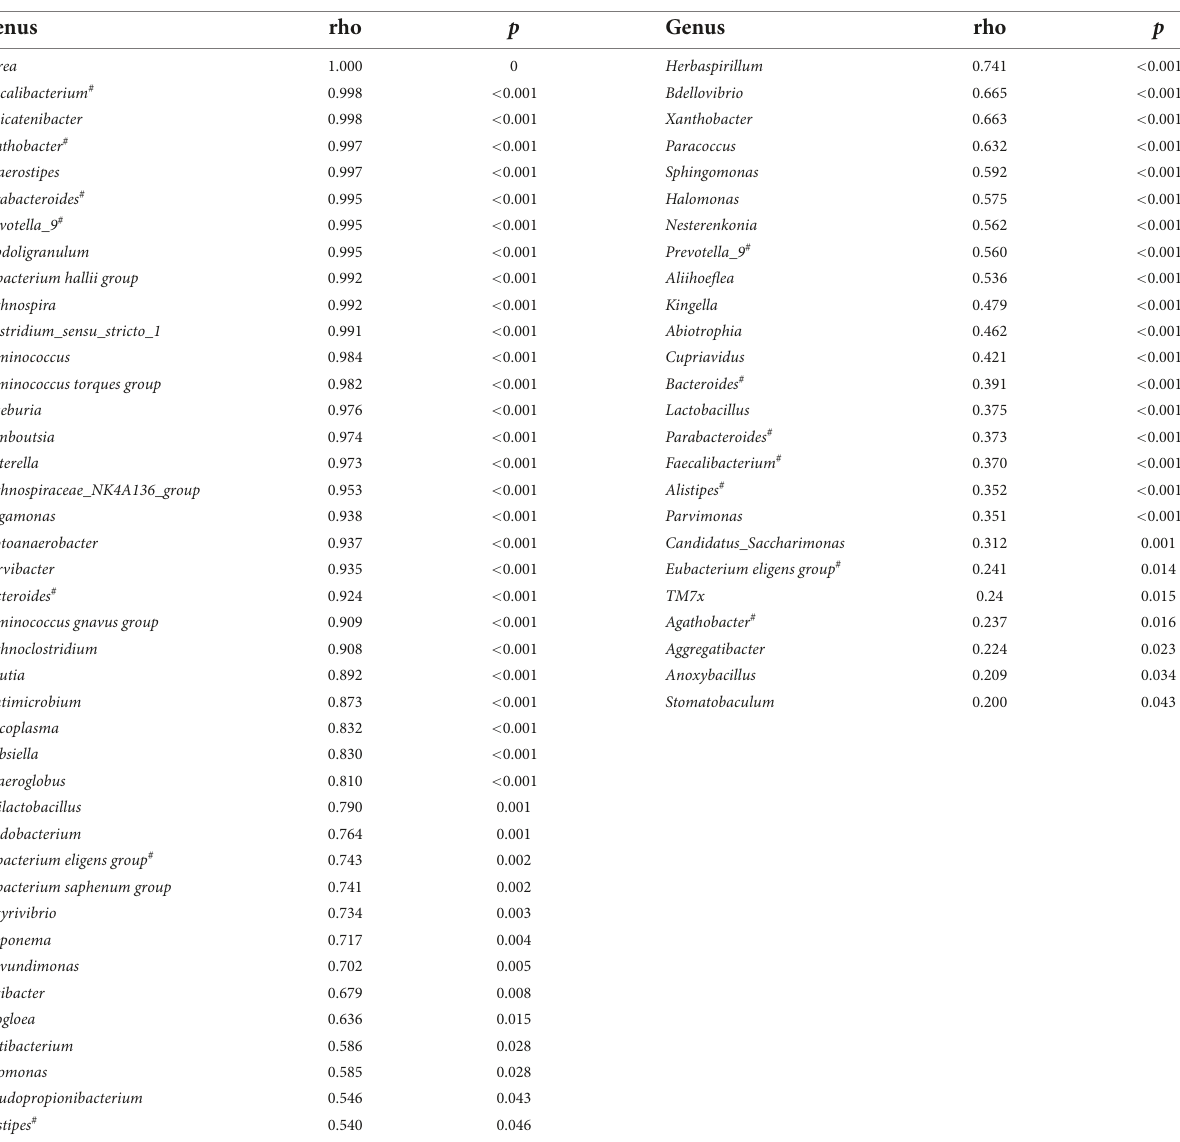
Spearman’s correlations and two-tailed p -value are displayed. Superscript “#” indicates the abundance of genera that were correlated in skin and pharynx in both the PP and GP groups.